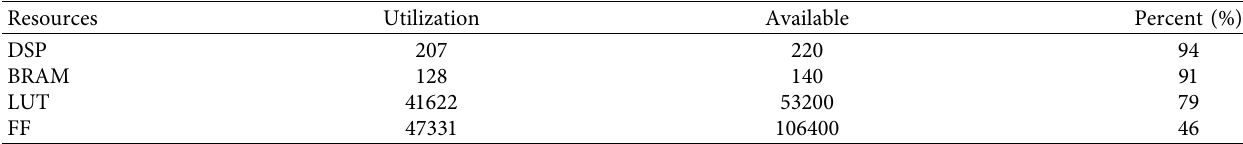
Table 5: Resource utilization of FPGA under optimal parameter confguration.